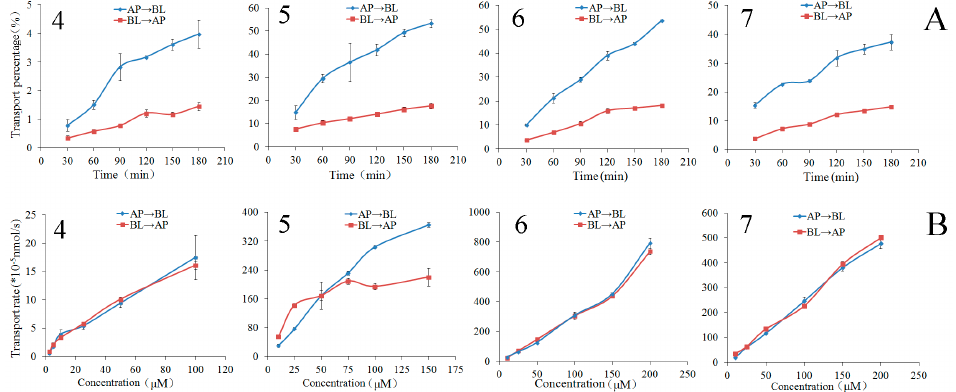
Figure 4. The transport percentage as a function of time at 50 µM ( A ) and transport rates as a function of concentration at 90 min ( B ) of the chalcones 4 – 7 in Caco-2 cell monolayer. Data are the mean ± S.D ( n = 3).